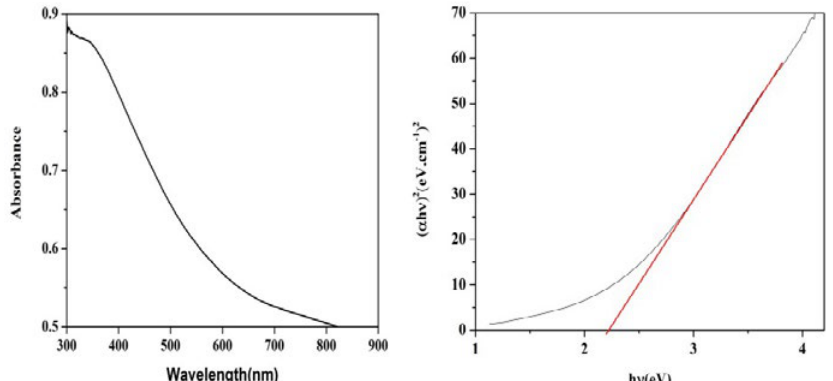
Fig. 4. UV-Vis spectrum and plot of the Tauc’s equation for the prepared crystalline